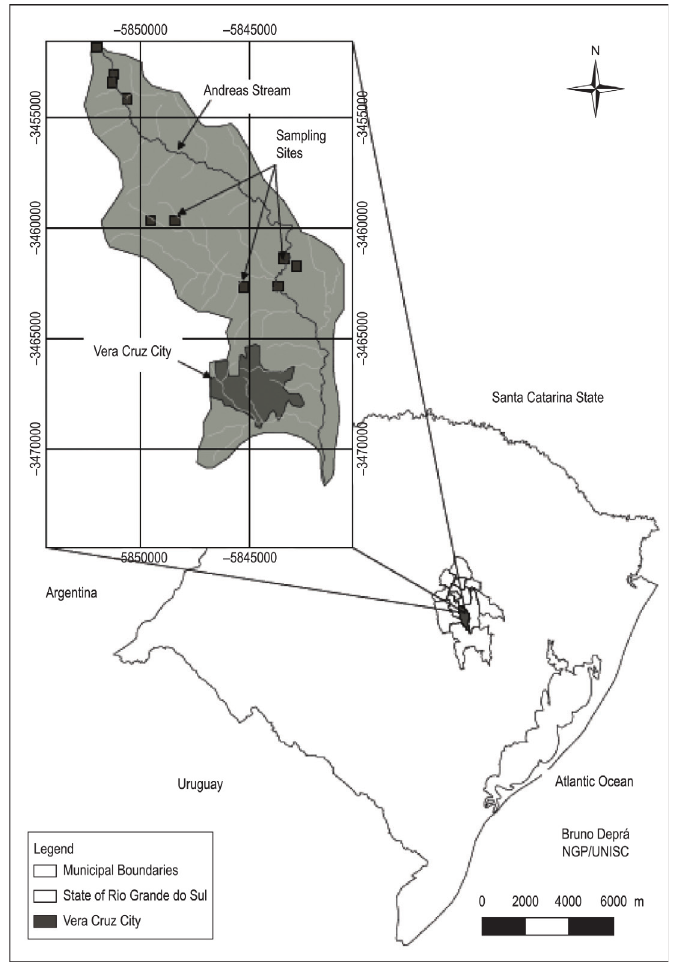
Figure 1. Map of the study area and localization of the Andreas Stream Sub-basin, in the municipality of Vera Cruz, RS,